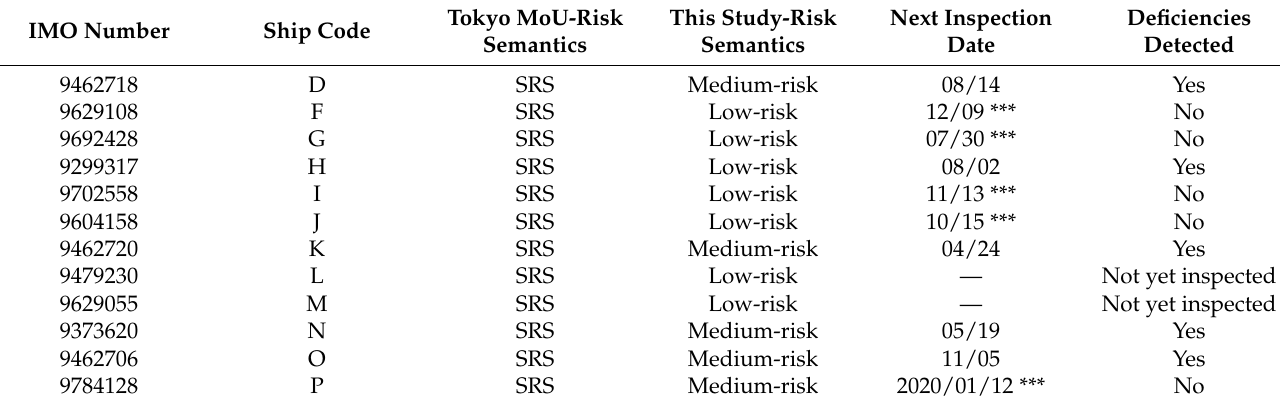
Table 13. Result of example